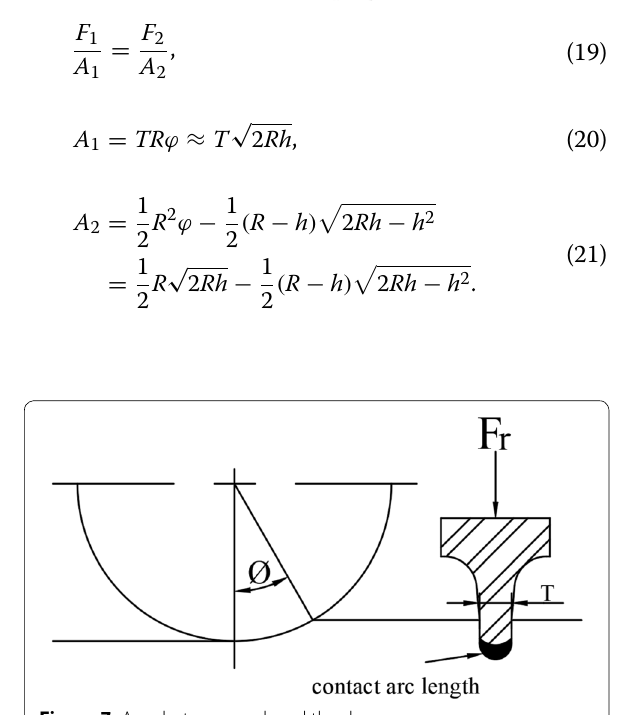
Figure 6 Area pressed by disc cutter in squeezing crushing phase Figure 7 Area between rock and the dense